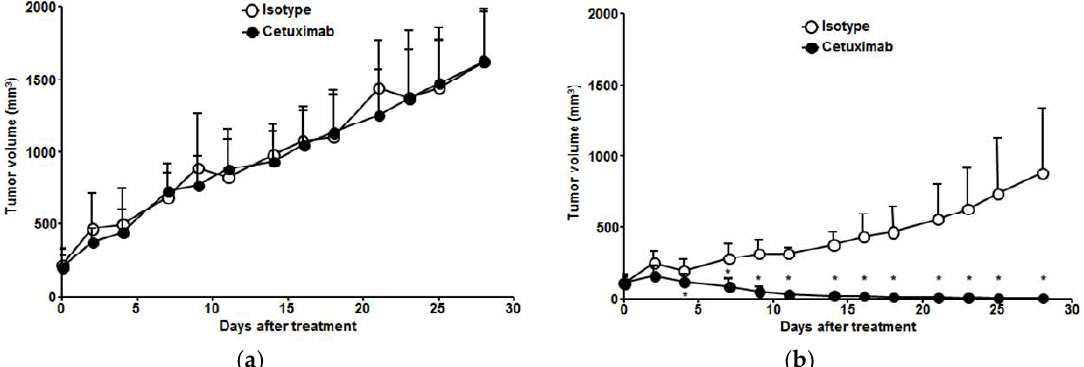
Figure 4. Antitumor effect of cetuximab in ESCC tumor models. Comparison of ( a ) TE-4 and ( b ) TE-8 tumor growth in ESCC xenograft model treated with isotype or cetuximab. Tumor growth in TE-4 was not inhibited by isotype or cetuximab treatment. TE-8 tumor markedly regressed with cetuximab treatment, but TE-8 tumor volume continuously increased with isotype treatment. * Isotype vs. cetuximab, p < 0.01.